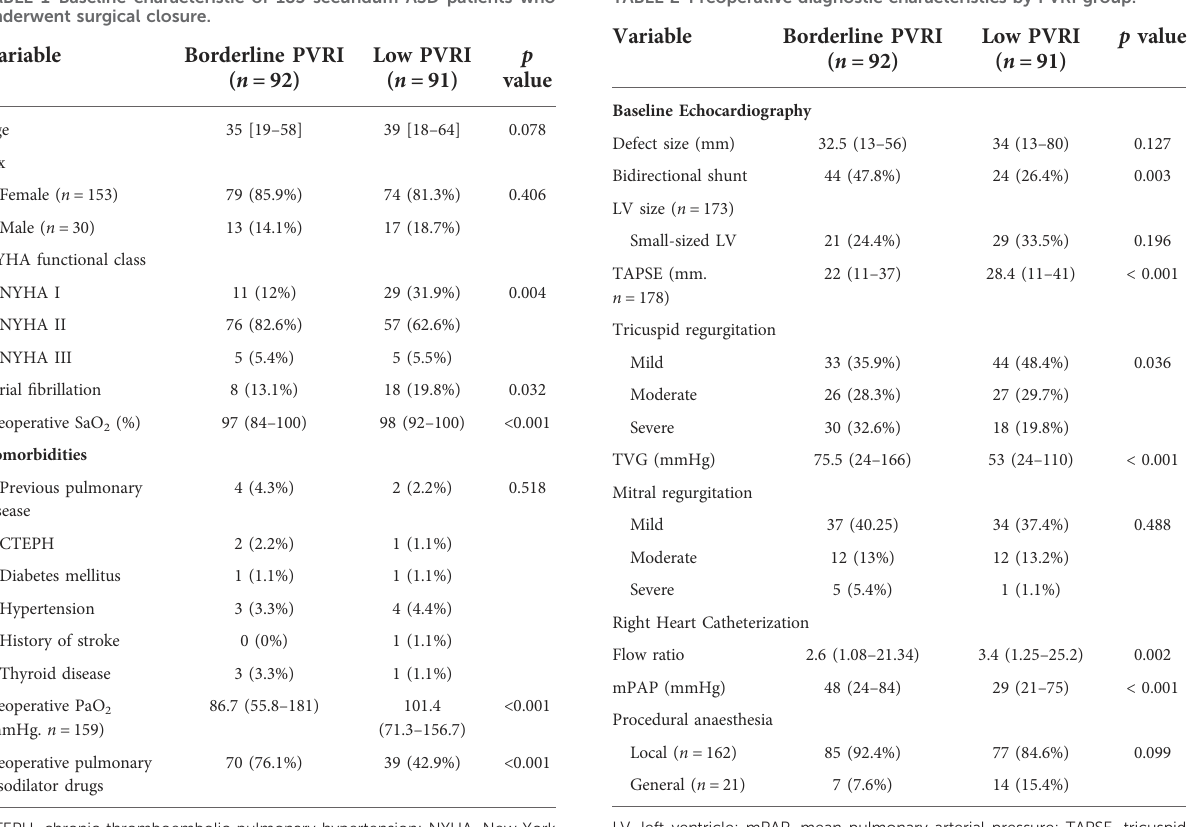
TABLE 2 Preoperative diagnostic characteristics by PVRI